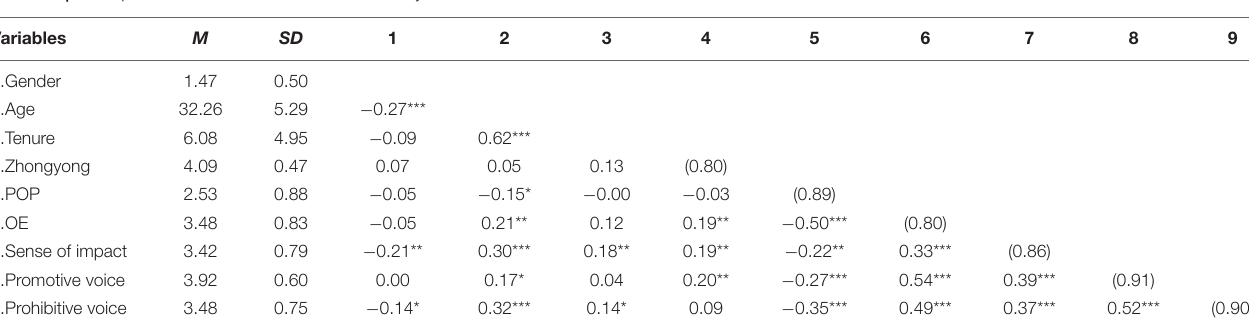
TABLE 2 | Descriptive statistics and correlations for study